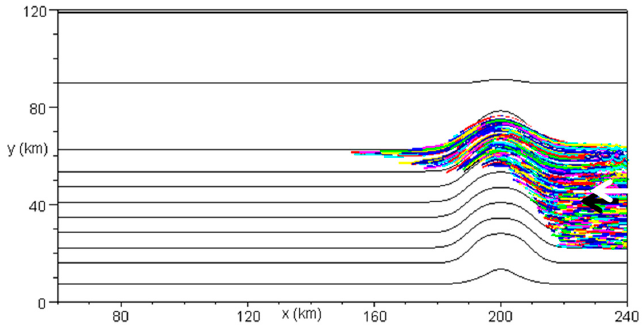
Figure 5. Topographic steering scenario. Trajectories of 3000 passive near-bottom drifters from day 5 to day 25 of the simulation. Black lines are isobaths. The arrow denotes the flow direction.